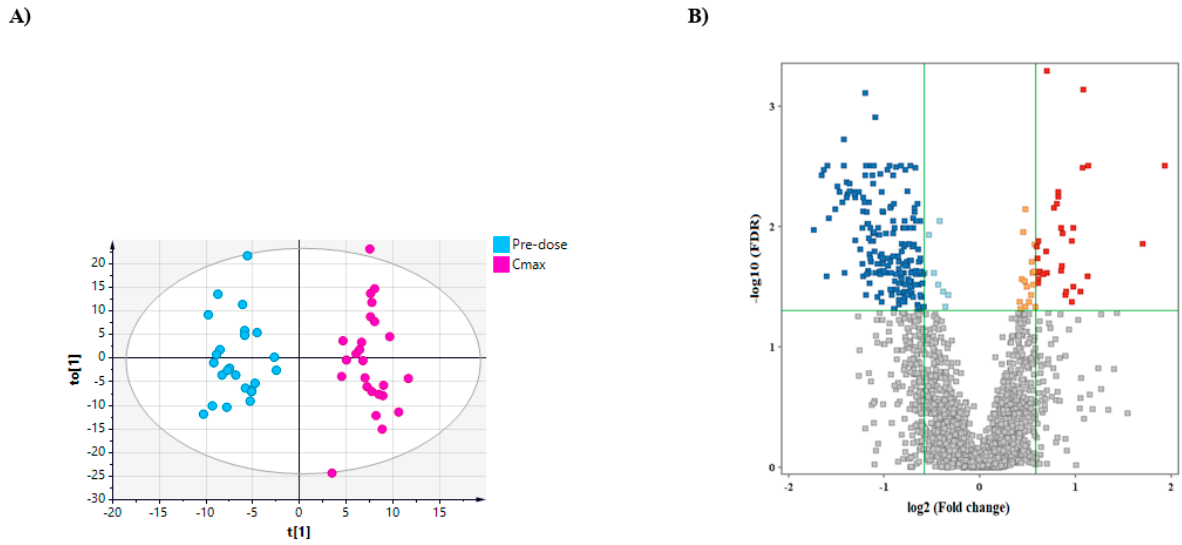
Figure 3. Differentially expressed lipids obtained from 26 subjects after metformin administration based on a binary comparison between baseline level (predose) and C max level. ( A ) OPLS-DA (R2X = 0.26, R2Y = 0.92, Q2 = 0.62) score plot predose (light blue) and at C max (purple). ( B ) Volcano plot (FDR value ≤ 0.05, FC 1.5) of upregulated (red, n = 33) and downregulated (blue, n = 192) features. Light blue and orange squares refer to lipids that failed to pass fold change cutoffs and were up- and downregulated, respectively. Gray square lipids failed to pass both cutoffs.